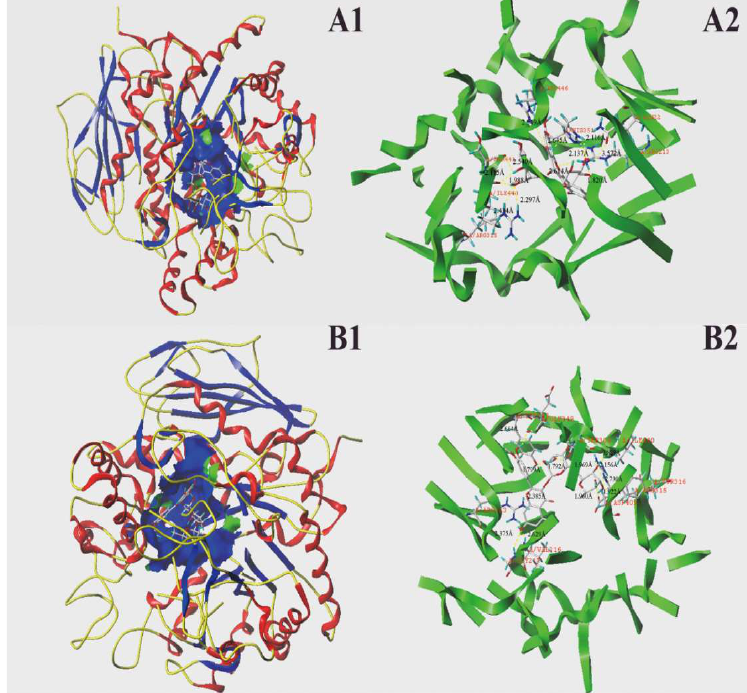
Figure 7. Molecular docking of two phenolic compounds with α -glucosidase. Two phenolic compounds were inserted into the hydrophobic cavity of α -glucosidase (blue) in the surface structure (( A1 ), rutin; ( B1 ), isorhamnetin-3- O -rutinoside). Interactions between two phenolic compounds and amino acid residues in the active site of α -glucosidase: rutin conformation ( A2 ), and isorhamnetin 3- O -rutinoside conformation ( B2 ), with residues in the active sites of the α -glucosidase, respectively. The dashed line stands for hydrogen bonds.